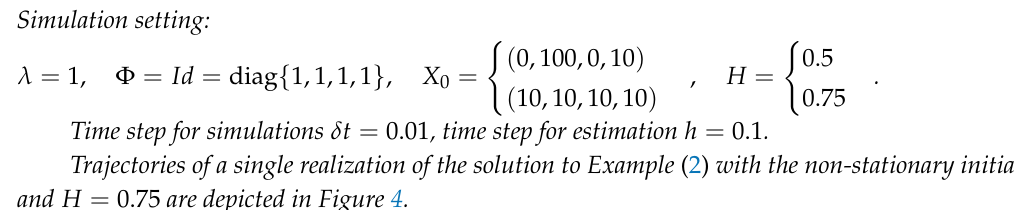
Figure 3. Stochastic heat equation on a complete